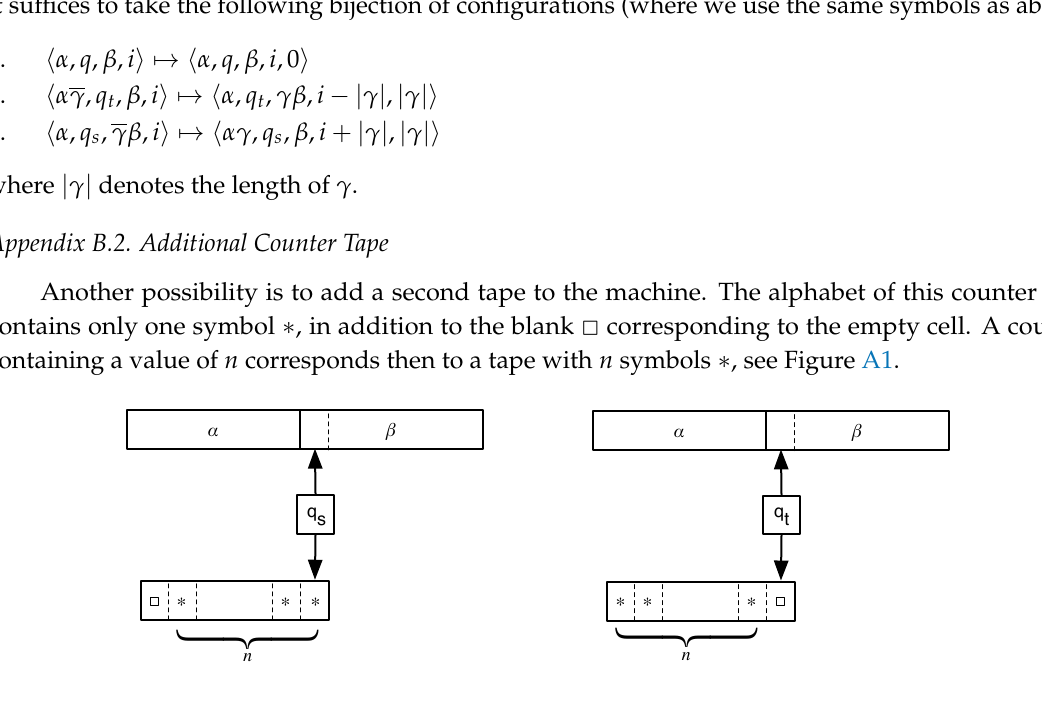
Figure A1. Implementation of the counter by means of a second tape with only one non blank symbol ∗